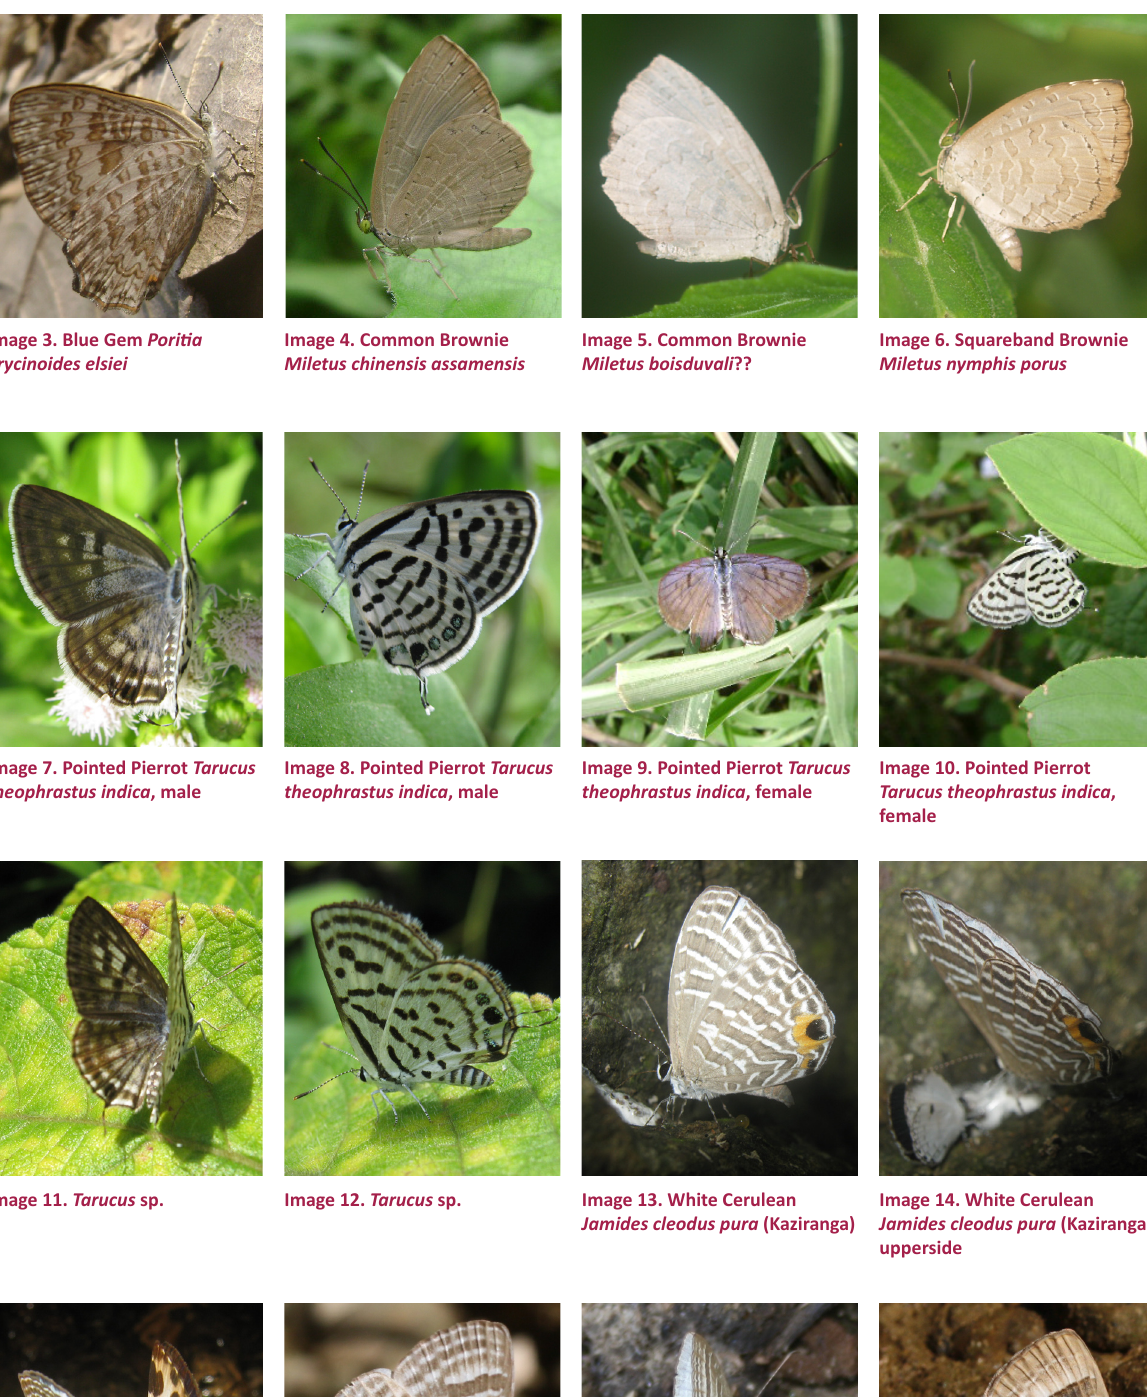
Image 11. Tarucus sp.